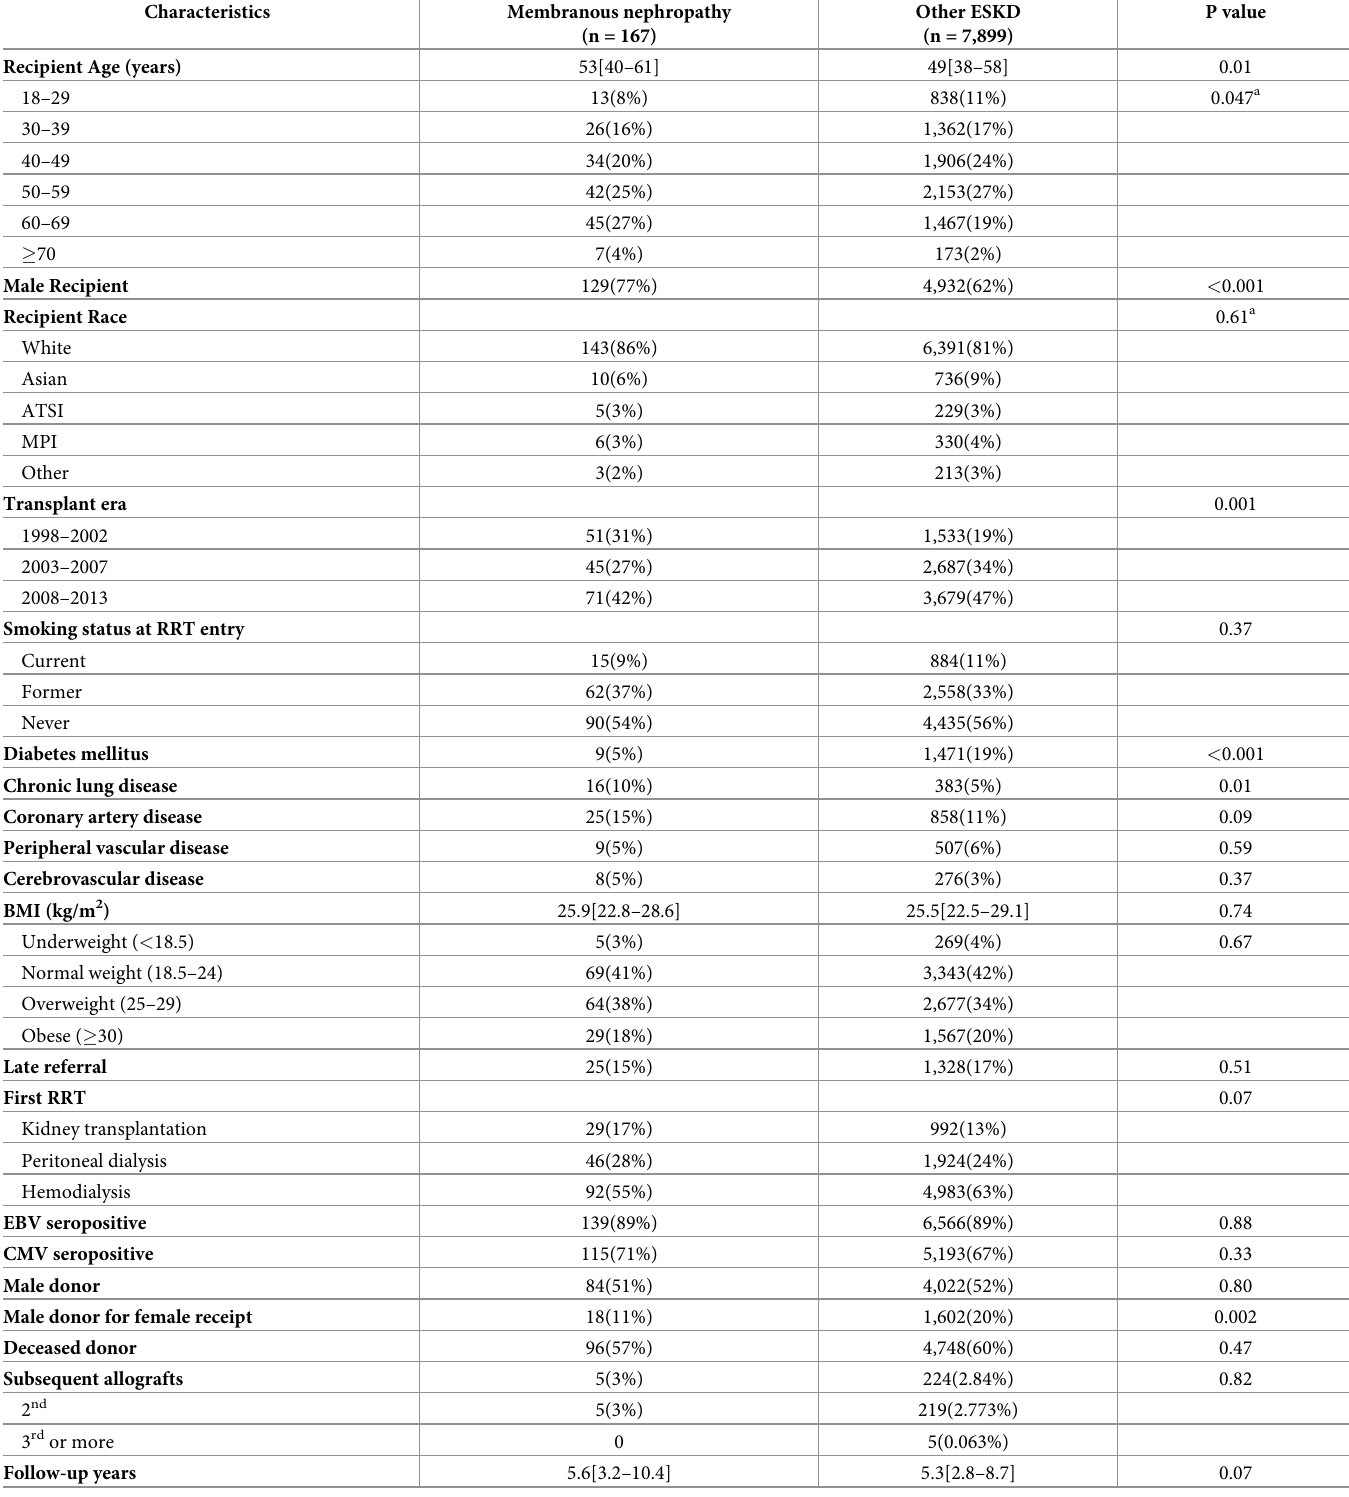
Table 2. Characteristics of patients undergoing first kidney transplantation for ESKD in Australia and New